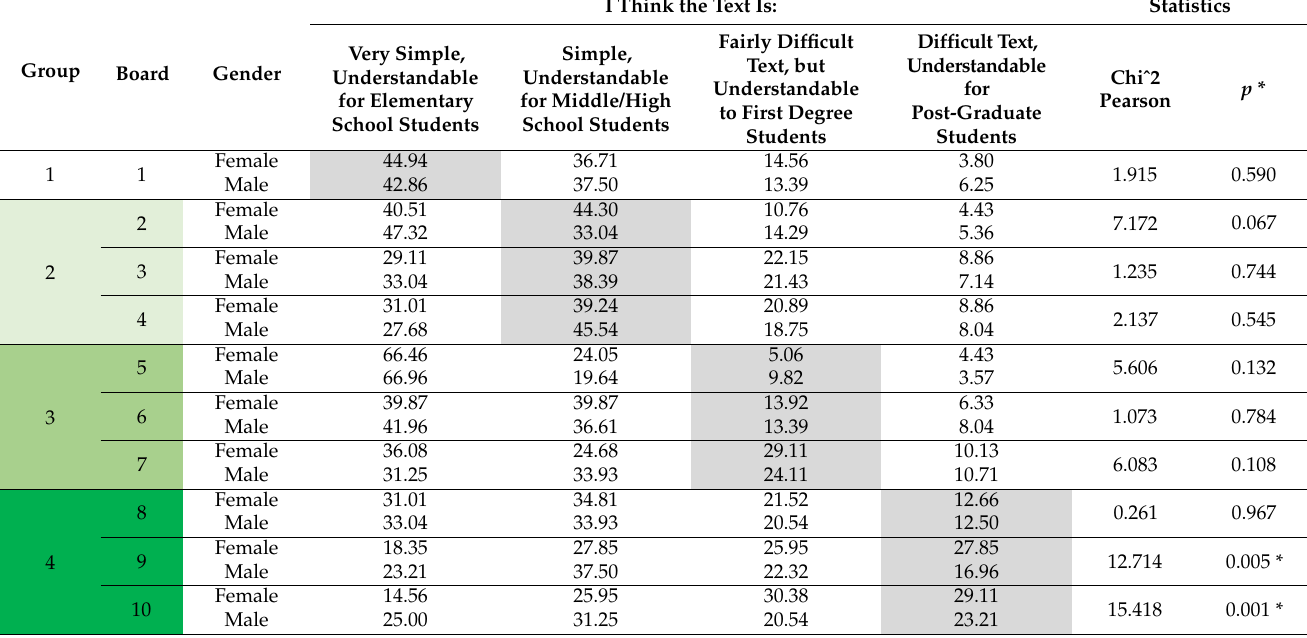
Table 6. Differences in the evaluation of the accessibility of the text on educational boards, taking into account the gender of